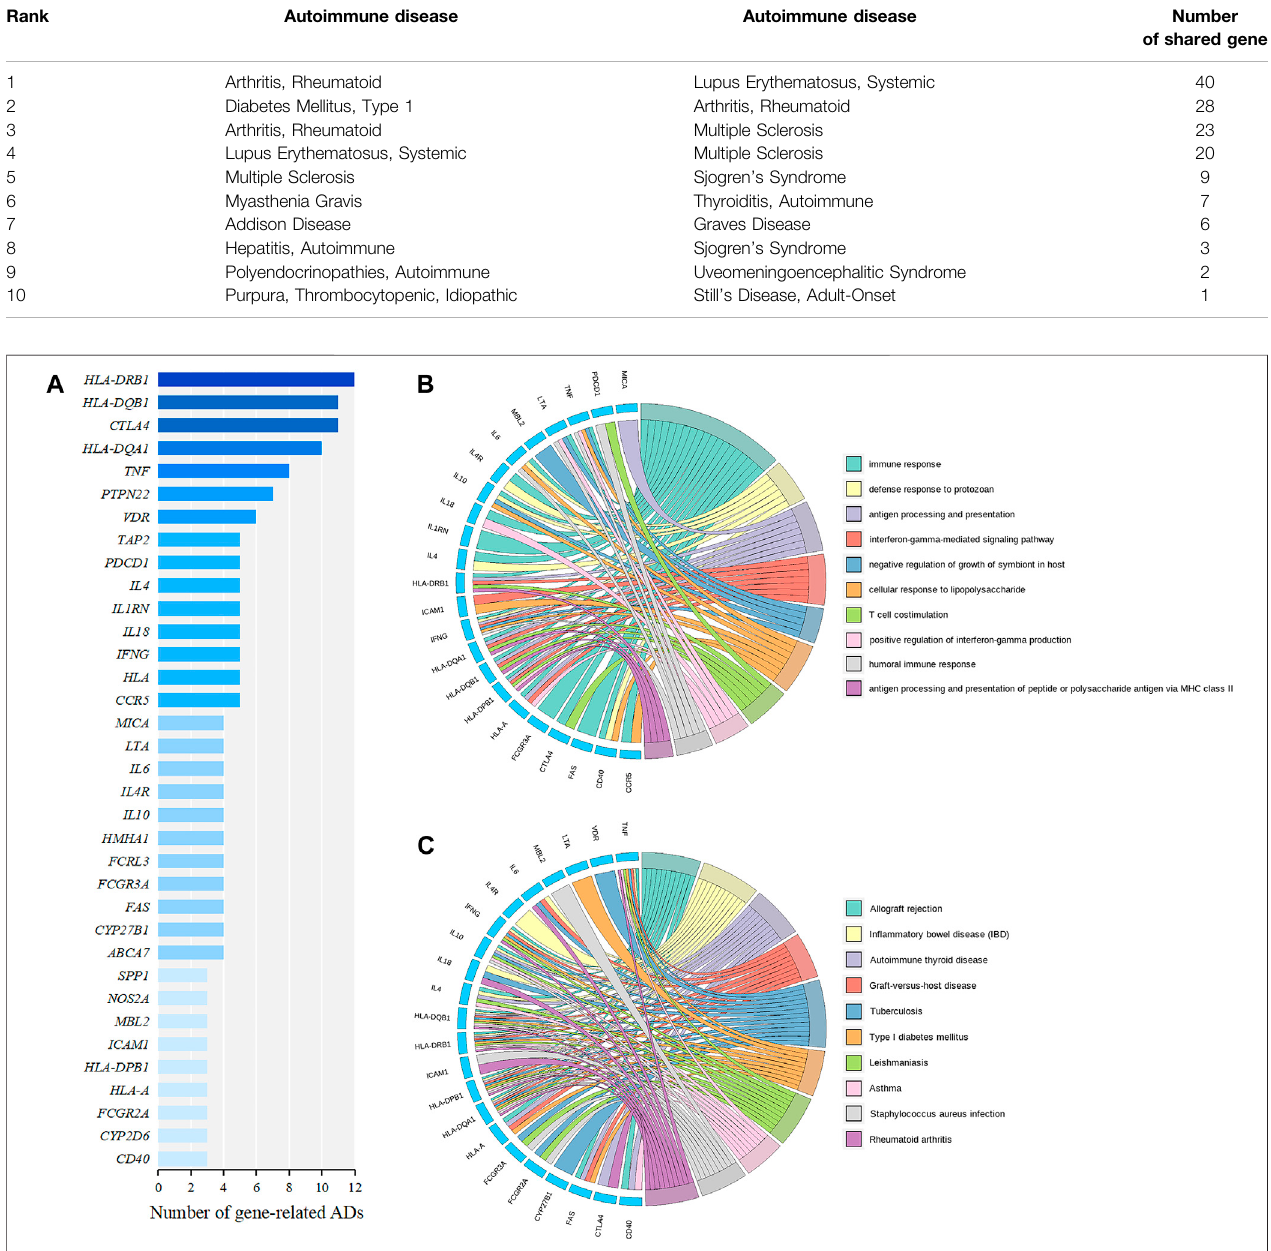
FIGURE 4 | Identi fi cation and functional enrichment analysis of AD relevant genes. (A) The genes correlated with at least three ADs derived from the AD similarity network, which are ranked by the number of related diseases. (B) Circos plot of top ten signi fi cant GO terms in the BP. (C) Circos plot of top ten signi fi cant KEGG pathways.Thegenesaredisplayedonthelefthalfofthecircosplots.TherighthalfrepresentsdifferentGOtermsorKEGGpathwayswithdifferentcolors.Ageneislinked to a certain GO term or KEGG pathway by the colored bands.